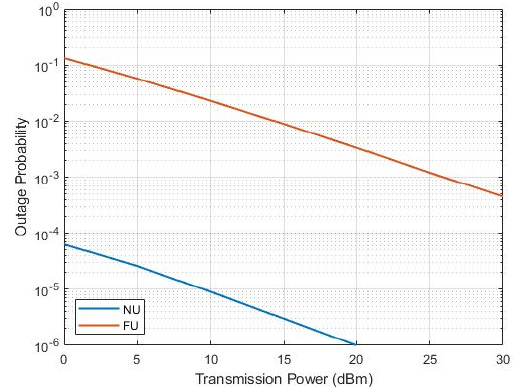
Figure 10. OP versus transmission power.